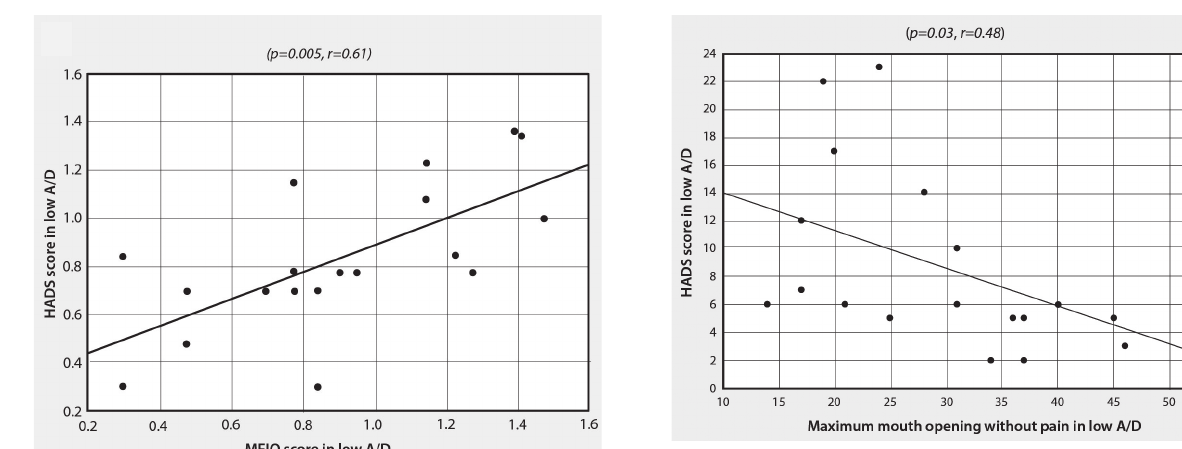
Figure 2- Correlation analysis of HADS score and MFIQ in low A/D HADS=Hospital Anxiety and Depression Scale, MFIQ=Mandibular Function Impairment Questionnaire, A/D=Anxiety/Depression Table 3- Spearman correlation coefficient and p-values between HADS score in high and low A/D for all variables addressed